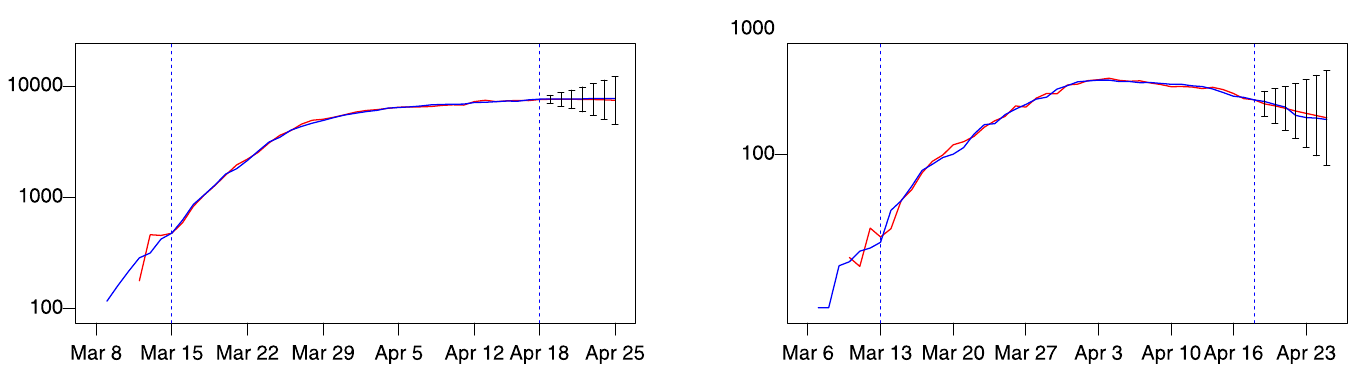
Fig 8. Spain (model d (2, 1)) and Switzerland (model d (1, 1)). Blue: actual; red: fitted (in estimation sample) or forecast (out-of-sample). Left: number of patients admitted in ICU in Switzerland. Right: number of patients admitted in ICU in Spain. Training sample within dashed vertical lines. Forecast intervals ± 3 standard errors.